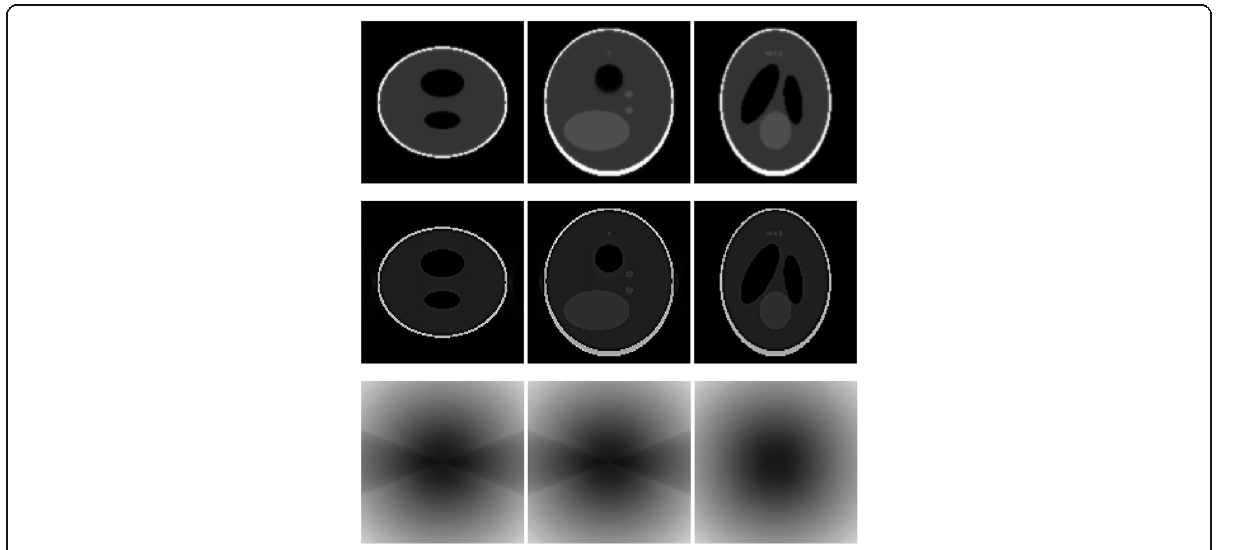
Fig. 9 Image reconstruction using proposed algorithm for the case of ψ = 3 π /8 and σ = 1. Row 1 : TOF backprojection. Row 2 : Final reconstruction. Row 3 : Tomographic filter H . Three central orthogonal cuts are shown for each